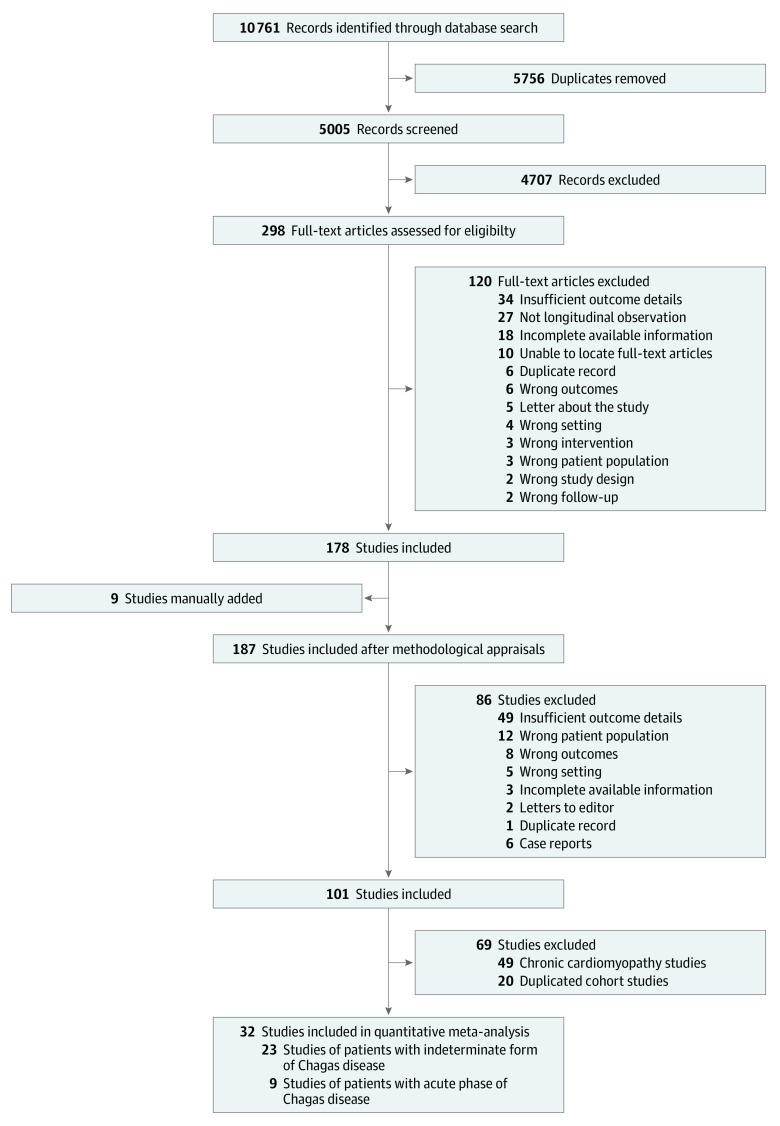
PRISMA Flow Diagram